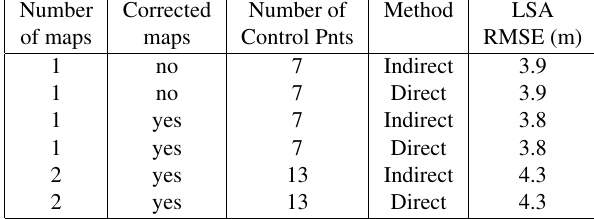
Table 6. The LSA fit error of all test cases in Thassos test